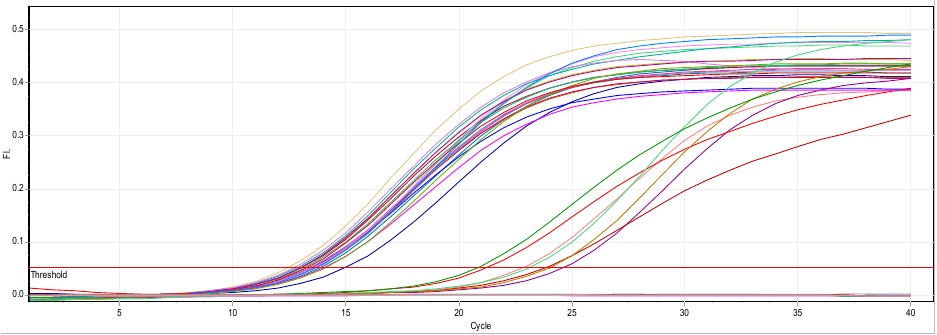
Figure 2. Real-time PCR results of the magA gene.